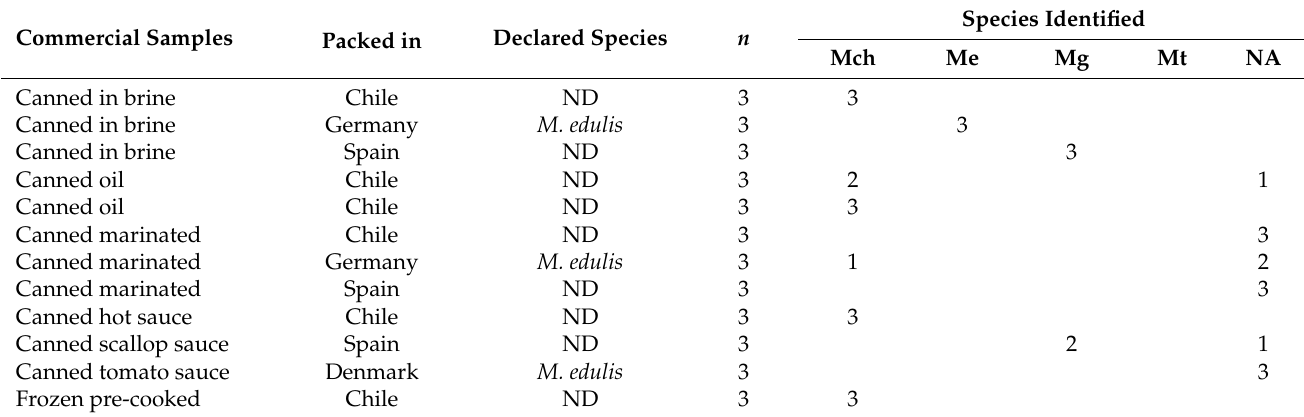
Table 4. Species identification in commercial